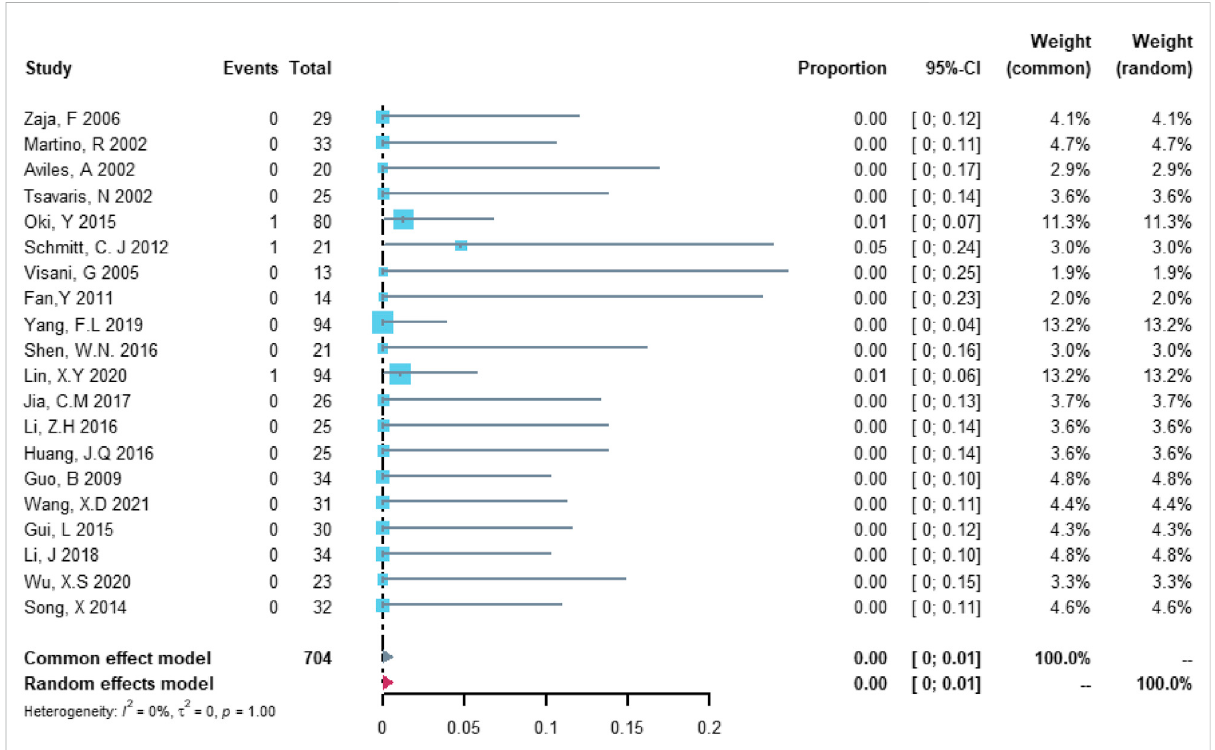
FIGURE 6 Summary pooledproportion analysis oftreatmentdiscontinuation events due to theleftventricular dysfunction or heartfailureassociated with the (R)-CDOP combination